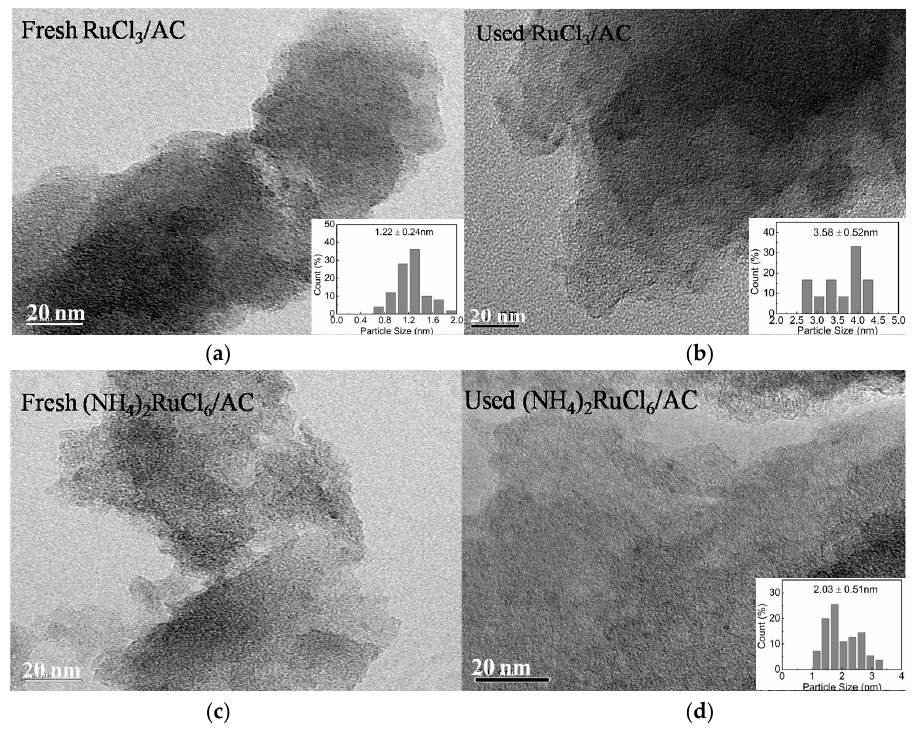
Figure 3. TEM images of the fresh and used Ru ‐ based catalysts with 1.0 wt % Ru loading. ( a ) Fresh RuCl 3 /AC; ( b ) Used RuCl 3 /AC; ( c ) Fresh (NH 4 ) 2 RuCl 6 /AC; ( d ) Used (NH 4 ) 2 RuCl 6 /AC.